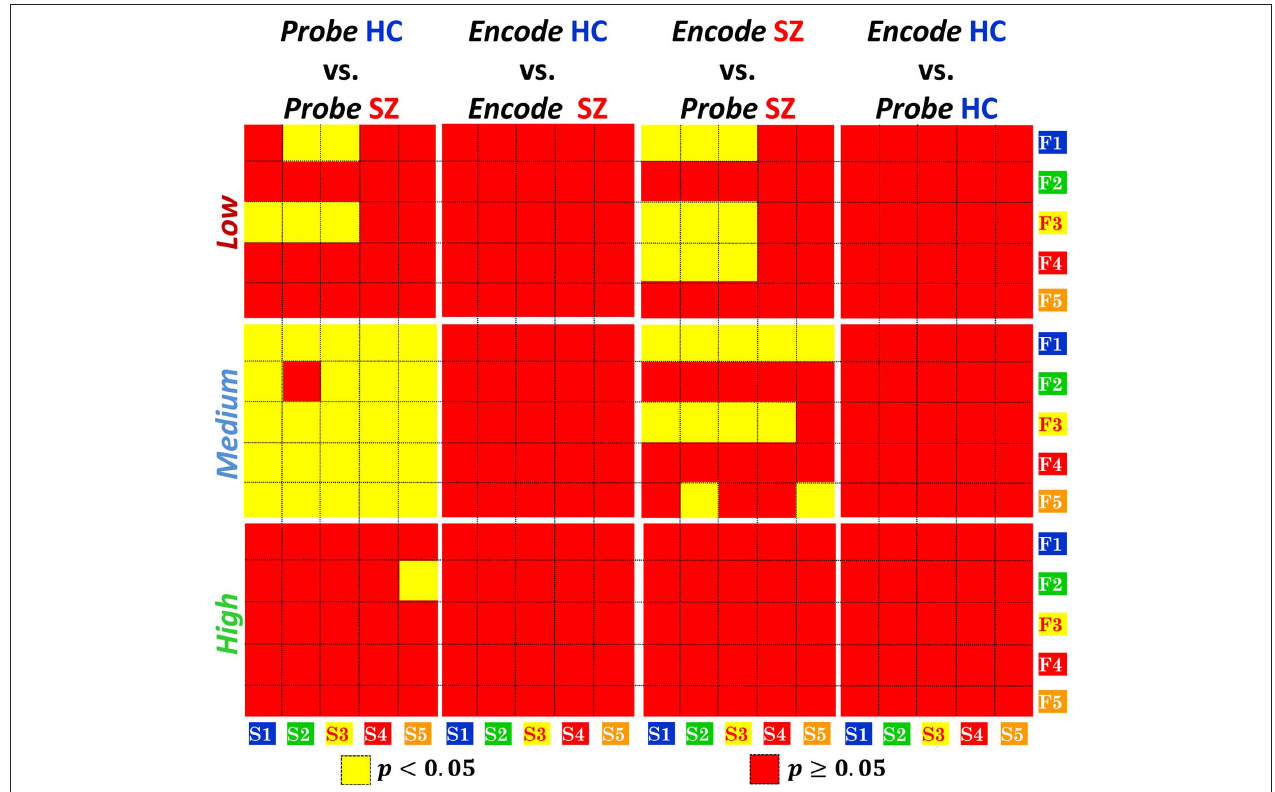
FIguRe 6 | Healthy control (HC) vs. patients with schizophrenia (SZ) and within group inter-cluster structure–function correlation differences for Encode and Probe across memory load levels. Correlations between structure/ function clusters of Figure 4 are computed across all load levels and significant